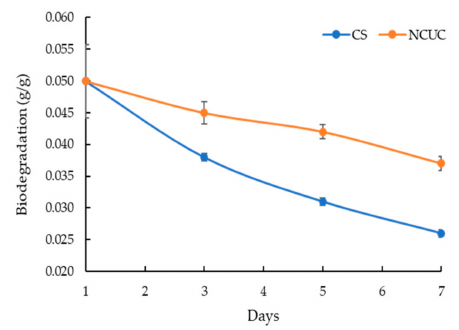
Figure 2. Biodegradation of the chitosan nanoparticles and NCUC